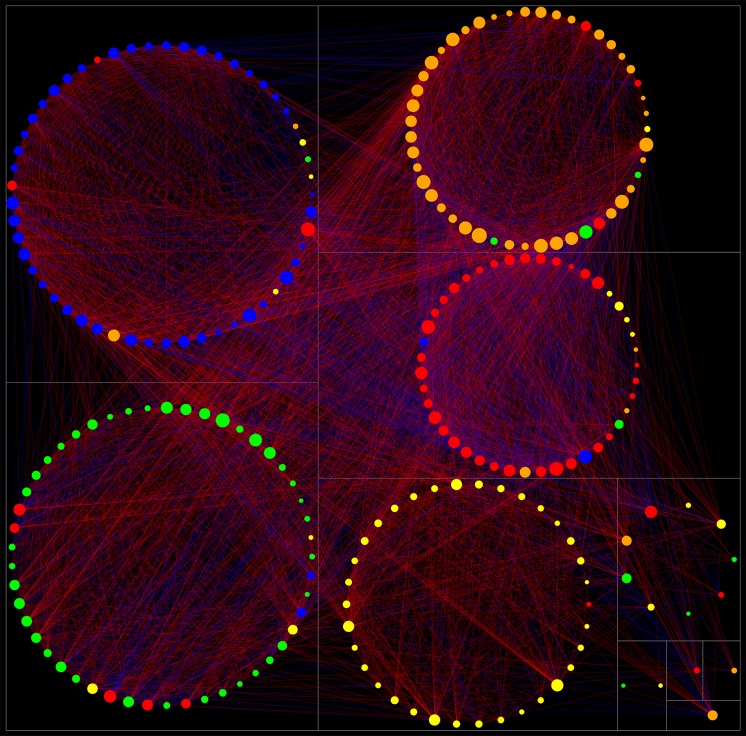
The Personality Web at item level: network graph of correlational relationships between the 240 items of the NEO-PI-R.The community structure of this graph has an overall best fit with the standard 5-FS, occurring at r = 0.164, p = 3.08E-04. Node = item, link = significant correlation. Red links: positive correlations. Blue links: negative correlations. Node size = degree (larger nodes are bigger hubs, scale = 1 to 10). For further information, see supporting information (Table S2). The color of the items refers to their standard factor membership, i.e. red: Neuroticism, orange: Extraversion, yellow: Openness, green: Agreeableness, blue: Conscientiousness. Items are grouped together according to their network cluster membership, and clusters are depicted as circles. Clusters are grouped according to size. Five clusters are found that show maximum correspondence to standard factors (Table 3,4). A small 6th factor is found (right in the graph), consisting of 9 items belonging to extraversion (1 item), openness (3 items), agreeableness (3 item) and neuroticism (2 items). Four isolates (bottom-right corner) consisting of 1 or 2 items were discarded from further analysis. Most of the top 10% hubs are located in the extraversion and neuroticism clusters.